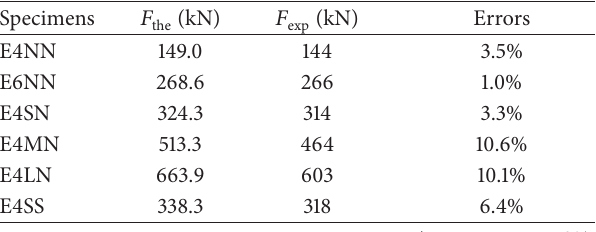
Table 7: Comparison of the field capacities derived from the theoretical and experimental